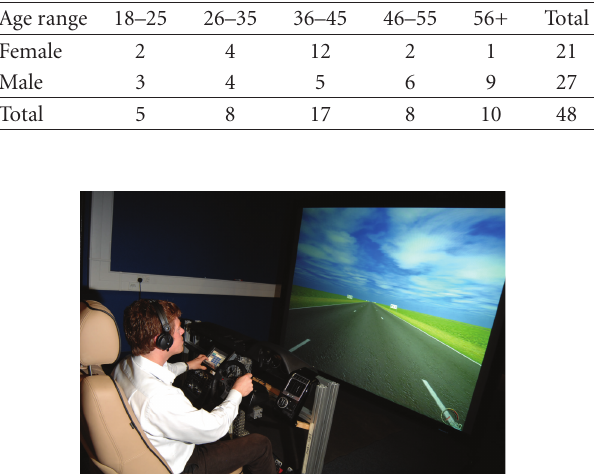
Table 1: Participant demographic breakdown.